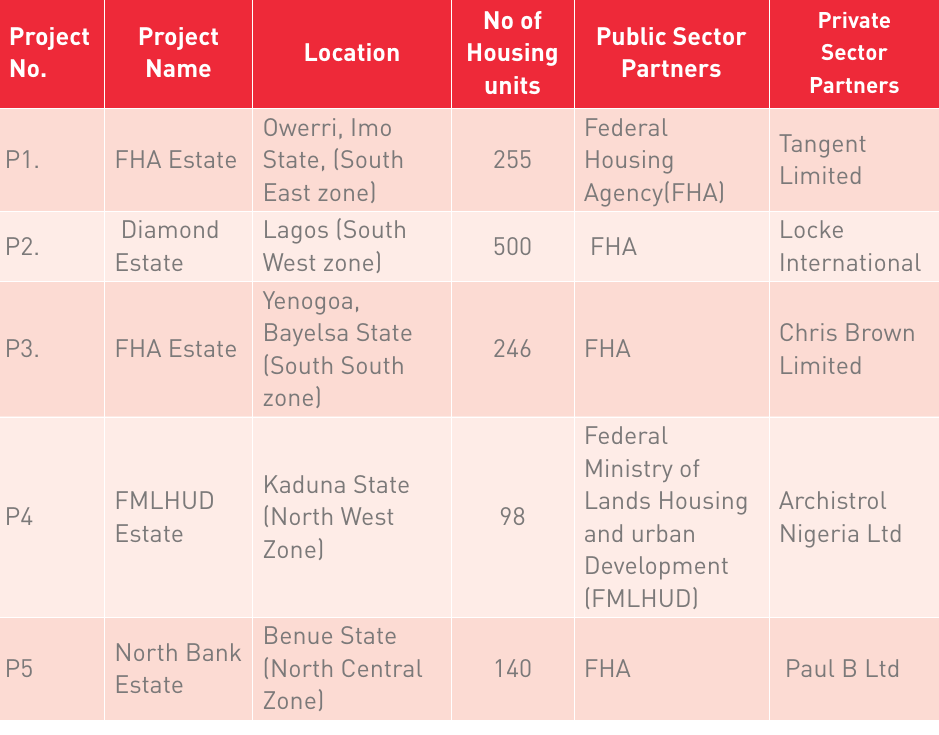
List of PPP Housing Projects from where Operators were selected